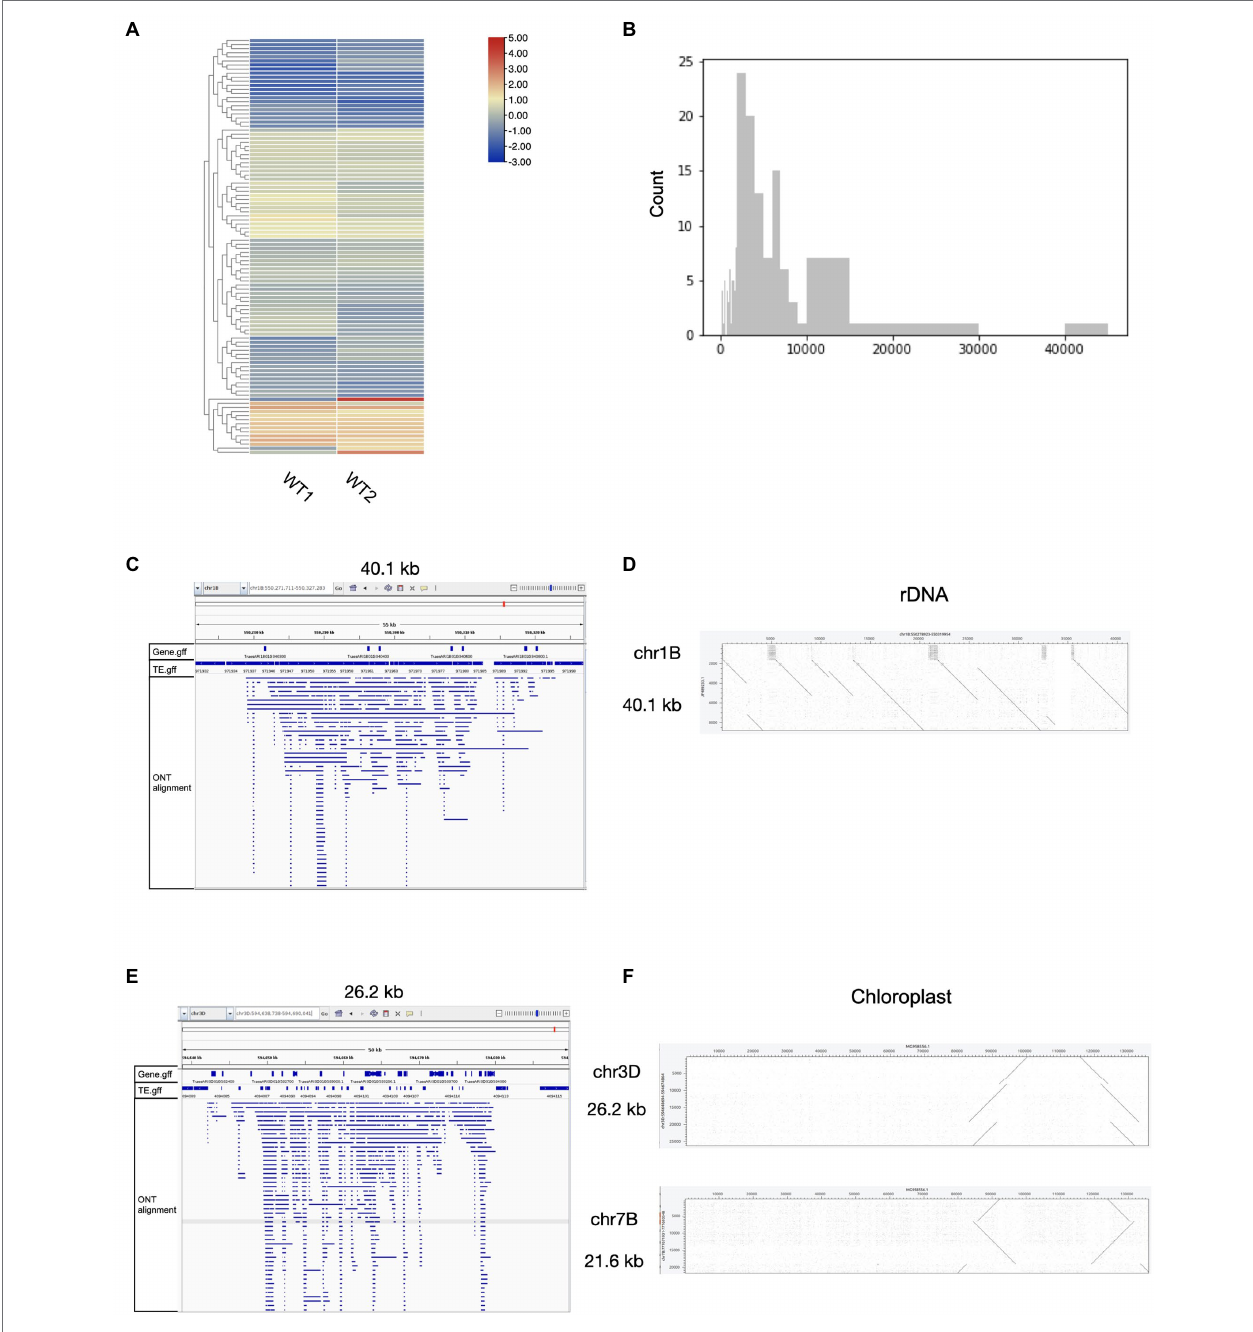
FIGURE 4 | Corresponding origins of eccDNAs loci detected by ecc_finder in wheat using mobilome-seq with Nanopore long reads. (A) Heat map of the 161 eccDNA sites detected using ecc_finder in the wheat wild-type (WT1, WT2) with two replicates, respectively. (B) Size distribution of the 161 detected eccDNAs. (C) Read distribution of the largest eccDNA-producing locus (40.1 kb) mapping to the reference genome. (D) Dot plot of the largest ecc-DNA-producing locus (26.2 kb) mapped to the reference genome. (E) Read distribution of the second largest eccDNA-producing locus (26.2 kb) mapped to the reference genome. (F) Dot plot of two eccDNA-producing loci (26.2 kb and 21.6 kb) and chloroplast genome,